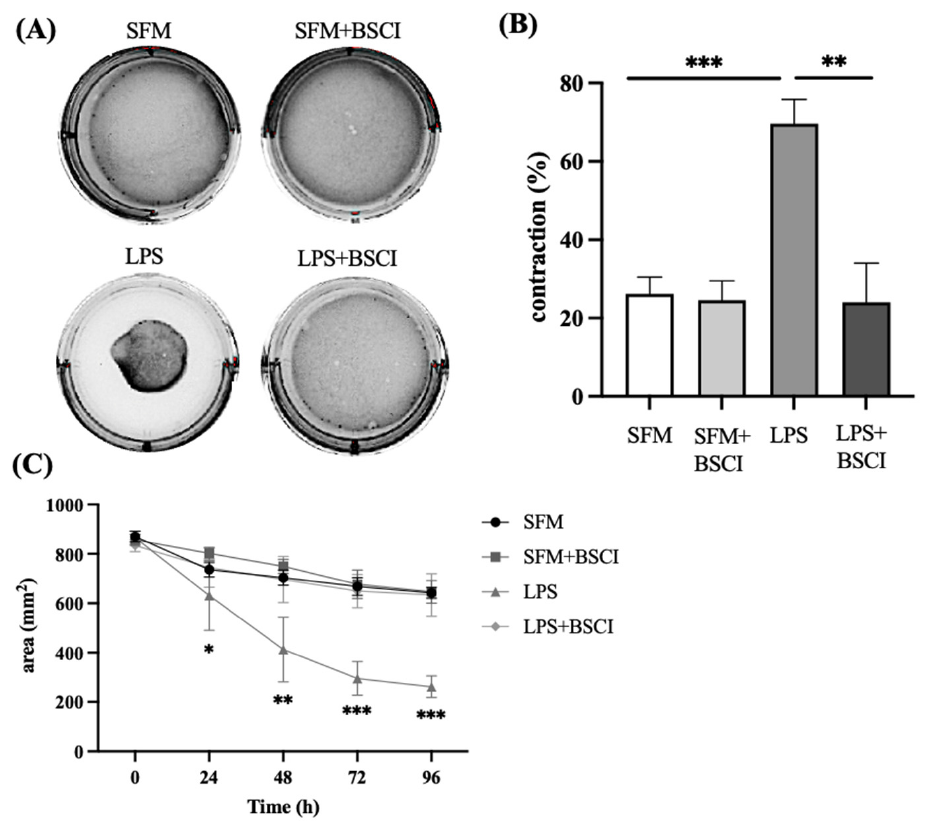
Figure 5. Effect of BSCI on LPS-induced myocyte–collagen gel contraction. ( A ) Photographs of collagen lattices containing human myometrial cells, induced with LPS (100 ng/mL) or vehicle (SFM) with/out BSCI (FX125L, 100 nM) for 96 h. ( B ) Bar graphs indicate the contraction of collagen lattices after 96 h of stimulation (% of the surface area of stimulated collagen gels at “96 h” compared to gels at time “0”). Data are pooled from n = 3 independent experiments. ( C ) Time-dependent changes in area of collagen lattices after LPS-stimulation with/out BSCI treatments. Individual human myometrial cell lines ( n = 3) were used with n = 4 technical replicates for every experimental condition. Data are presented as mean ± SD. Statistical significance was determined by one-way ANOVA followed by Dunnette’s multiple comparisons test. ‘*’ denotes statistical significance at p < 0.05, ‘**’ at p < 0.01, and ‘***’ at p < 0.001.